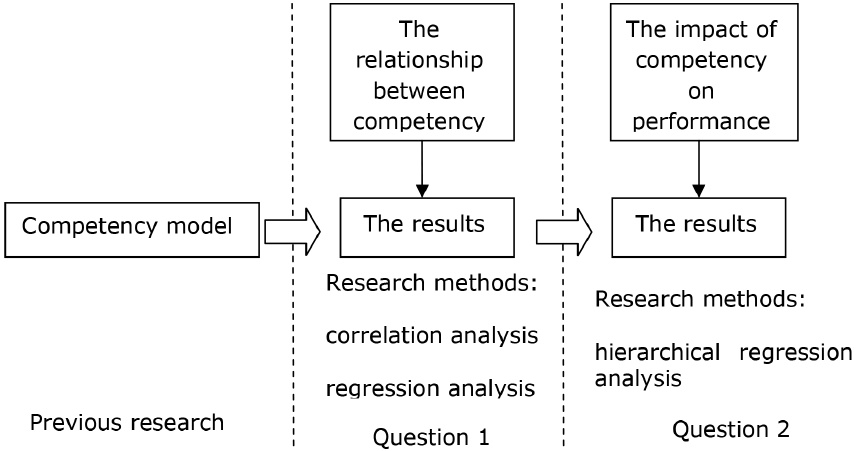
Figure 1. Research